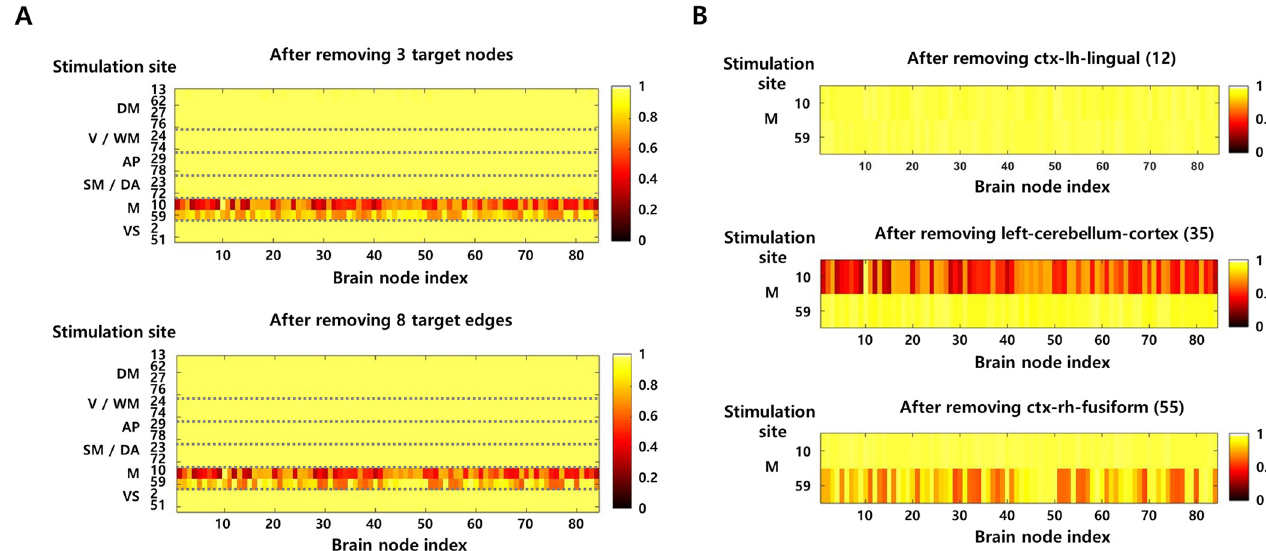
Fig 3. Safety evaluation of the TZs. A Network simulation results for safety assessment. When stimulation is applied to the brain nodes that can reproduce each RS network, the difference between response signals before and after removing TZs (3 target nodes or 8 target edges) is presented as the similarity coefficient. The similarity coefficient is calculated independently in all brain nodes, and the color code of the figure indicates the value of the similarity coefficient. Detailed information on stimulation site is provided in the materials and methods section. B Identification of the critical node. When each node belonging to the initially obtained target nodes is eliminated, the degree of alteration of the response network (corresponding to the memory network, M) is represented as the similarity coefficient.